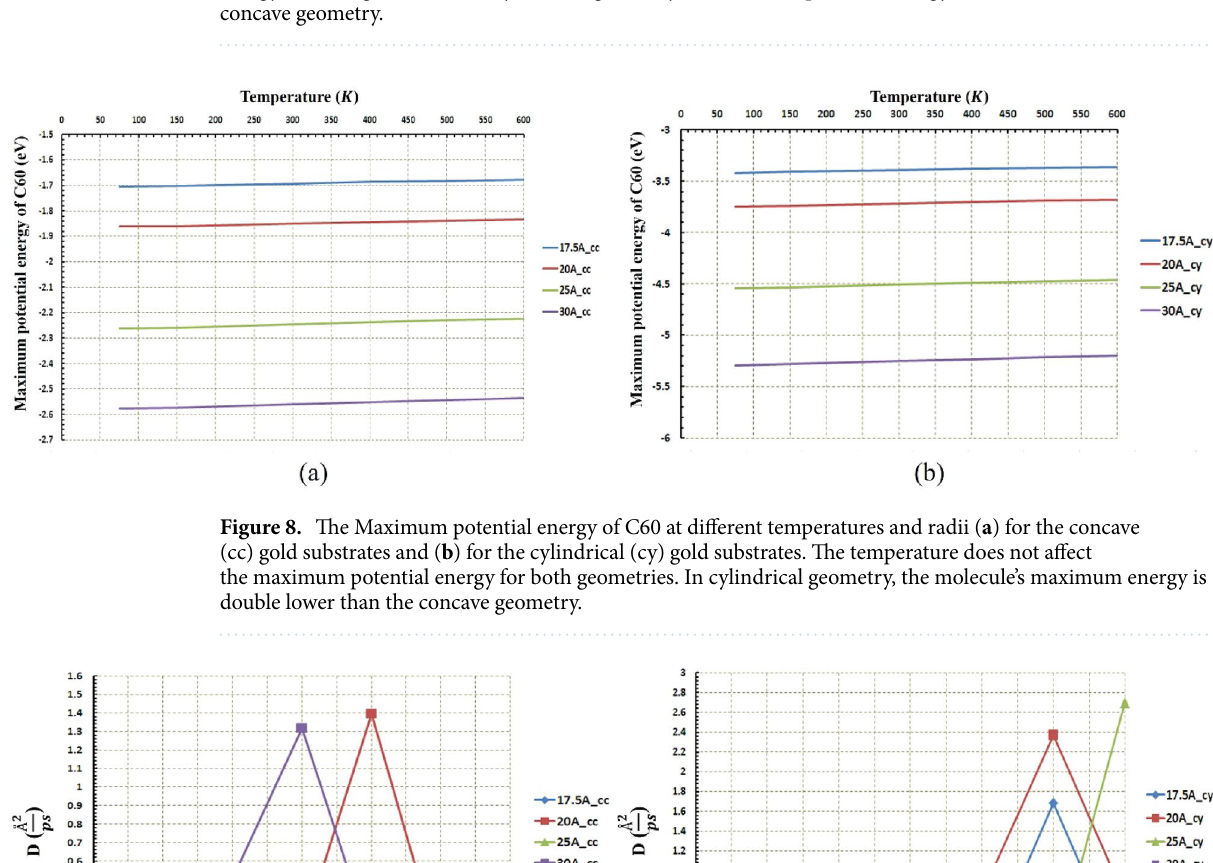
Figure7. The average potential energy of C60 at different temperatures and radii ( a ) for the concave (cc) gold substrates and ( b ) for the cylindrical (cy) gold substrates. The temperature does not affect the average potential energy for both geometries. In cylindrical geometry, the molecule potential energy is double lower than the concave geometry.